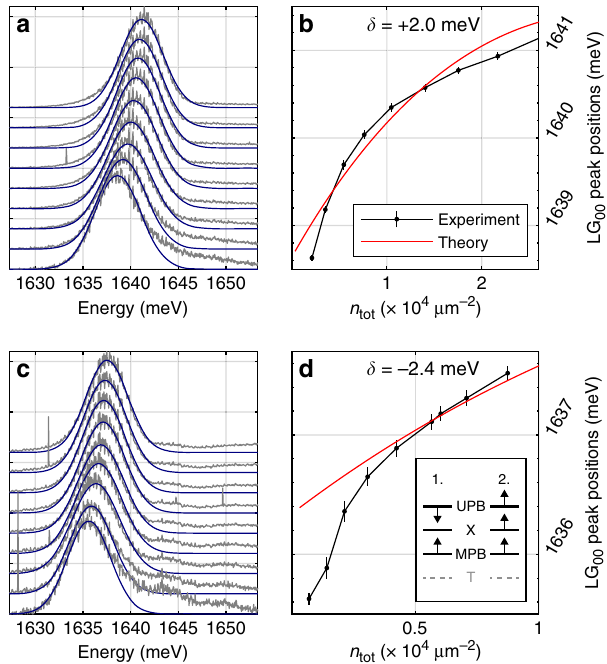
Fig. 4 Neutral exciton – polariton nonlinearity. a , b Small positive detuning δ = + 2.0 meV is considered. a Spectra of the MPB LG C – X 00 mode for the pump powers from 1 to 9 μ W (power increases from bottom to top). b Extracted peak positions of the mode vs. exciton density. c , d Small negative detuning δ C – X = − 2.4 meV is considered. c Spectra of the MPB LG 00 mode for the pump powers from 1 to 9 μ W (power increases from bottom to top). d Extracted peak positions of the mode vs. estimated exciton density. The error bars (95% CI) in ( b – d ) are deduced from the fi tting procedure in ( a – c ). Red solid curves correspond to the theoretical modelling results. Inset: schematic diagrams showing how the MPB and UPB shift in the case of phase space fi lling (Mechanism 1 leading to reduction of Rabi-splitting between neutral exciton level and the bare photon mode) and the neutral exciton blueshift (Mechanism 2).